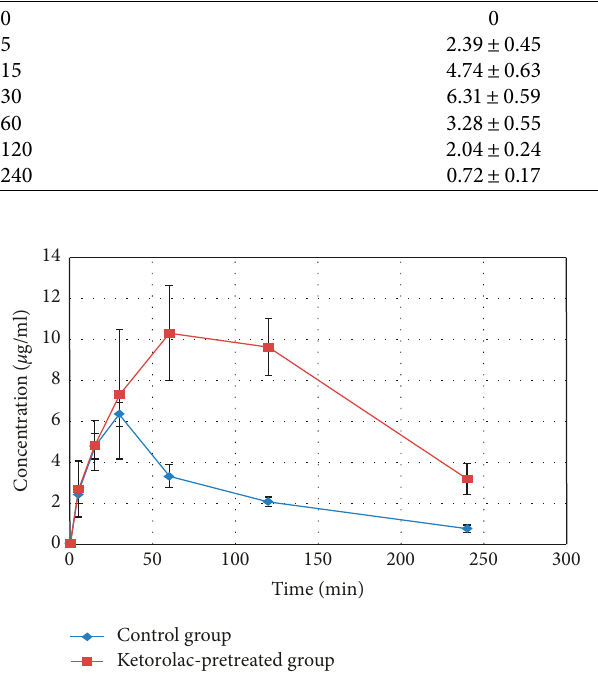
Figure 3: Mean ± SD of plasma concentration of 5-FU (50mg/kg, i.p.) in the control group and the ketorolac-pretreated